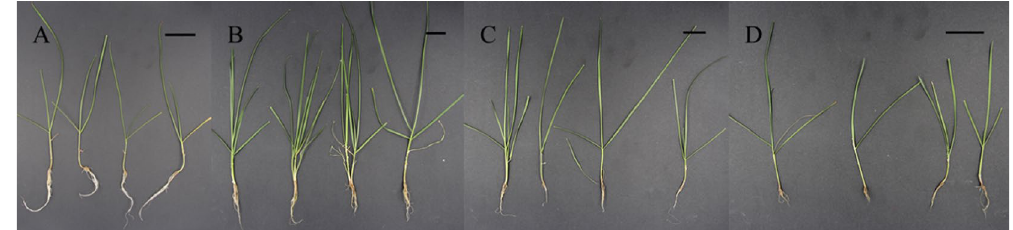
Figure 1. Growth state of perennial ryegrass under different treatments. ( A – D ) represent treatments N0, N0.5, N1, and N10, respectively. The black scale bar in each figure indicates 3 cm.